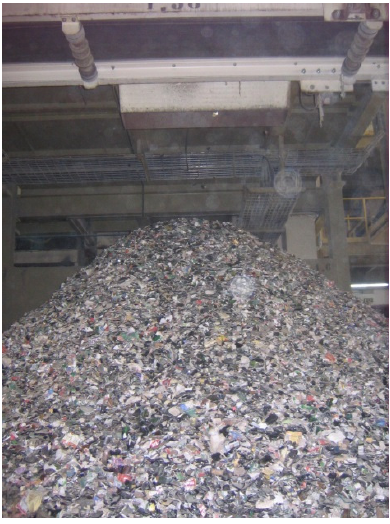
Figure 1. Residues of optical classification.